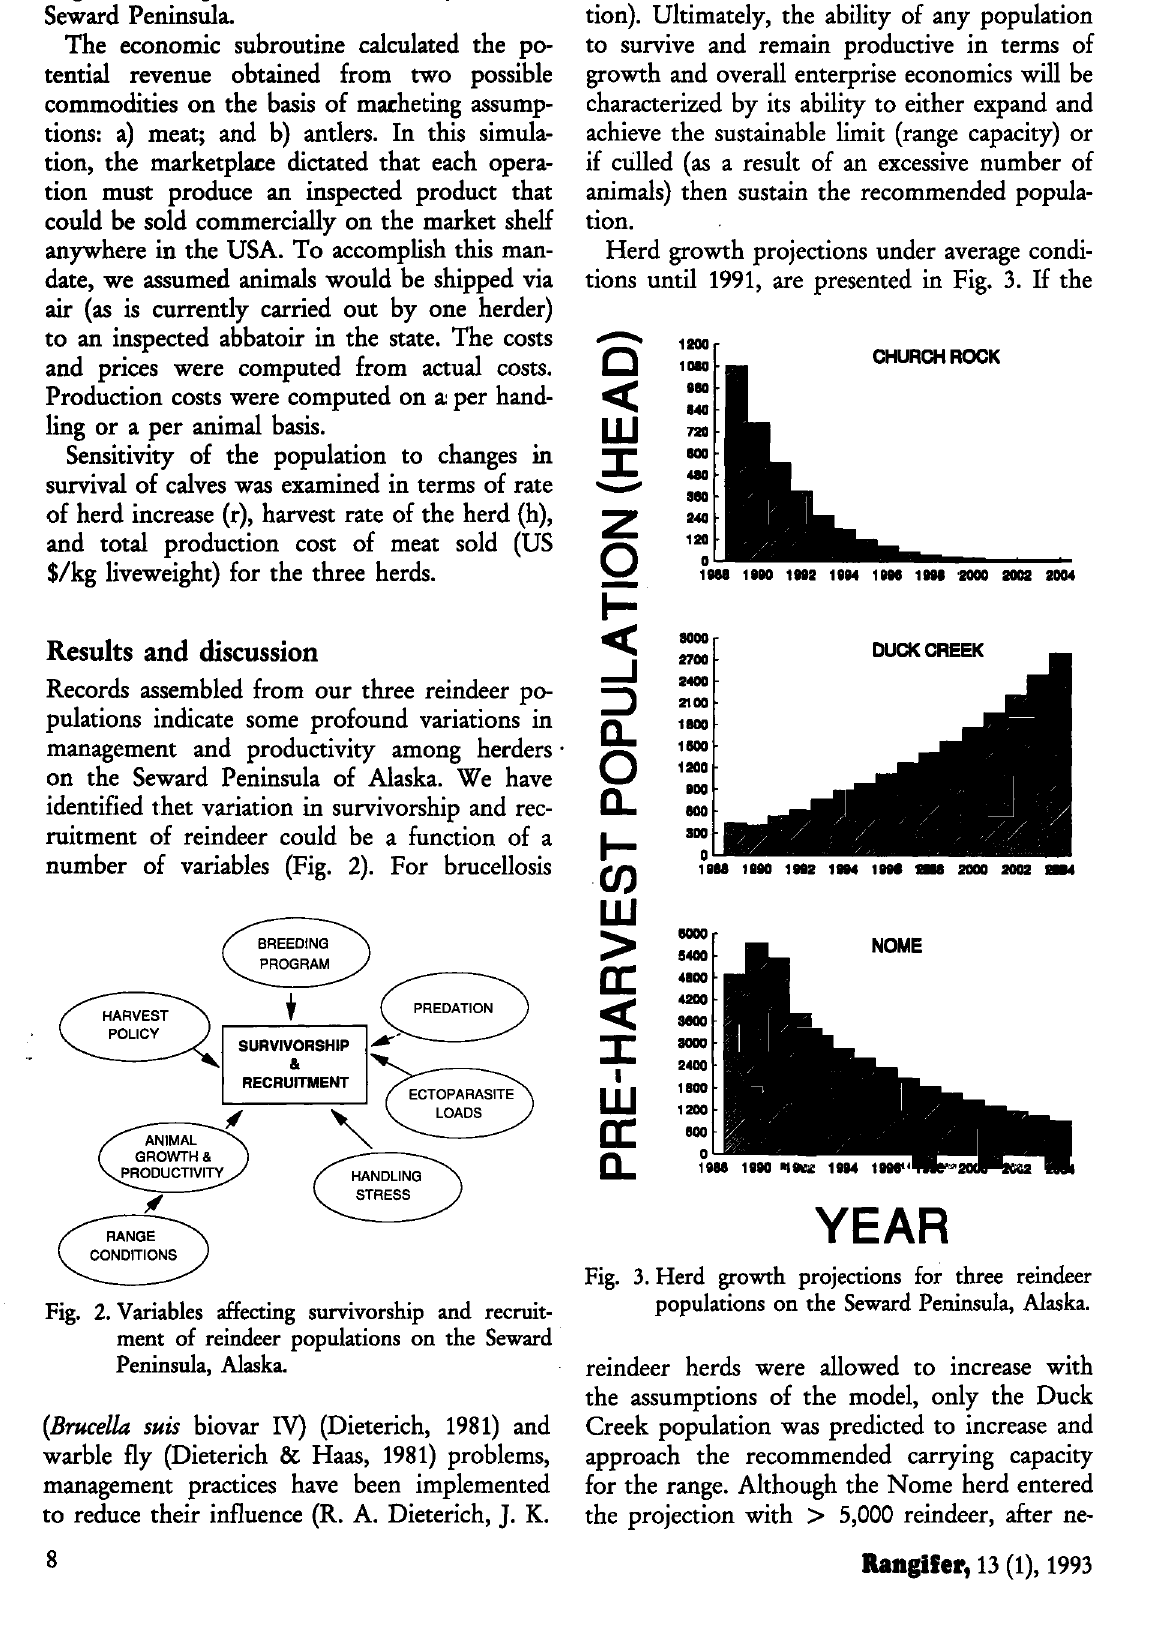
Fig. 2. Variables affecting survivorship and recruit ment of reindeer populations on the Seward Peninsula, Alaska.